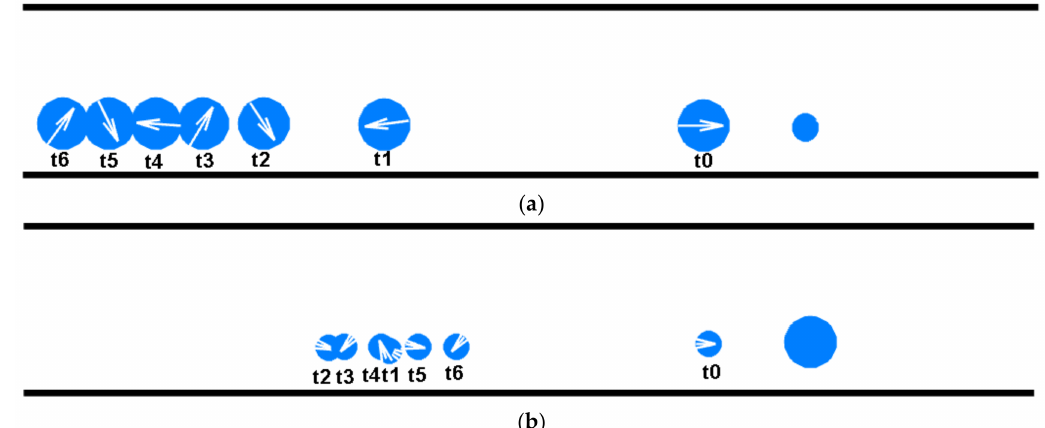
Figure 10. Schematic diagram of particle movement (the downstream particle is relatively immobile); ( a ) Small particle is downstream; ( b ) Big particle is downstream.